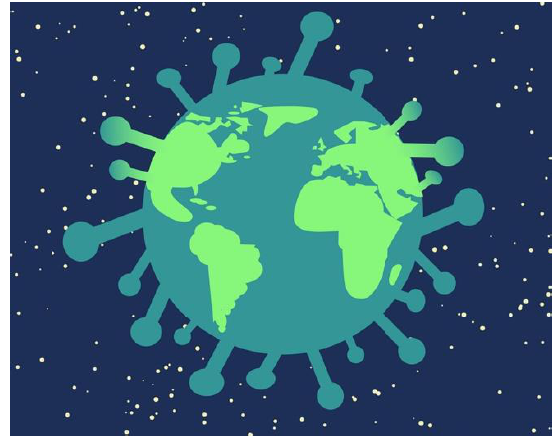
Figure 4. The Covid-19